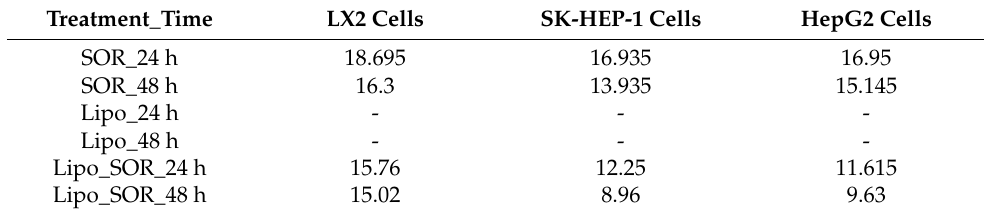
Table 2. IC50 concentrations ( µ M) of SOR, Lipo, and Lipo_SOR. Treatment_Time LX2